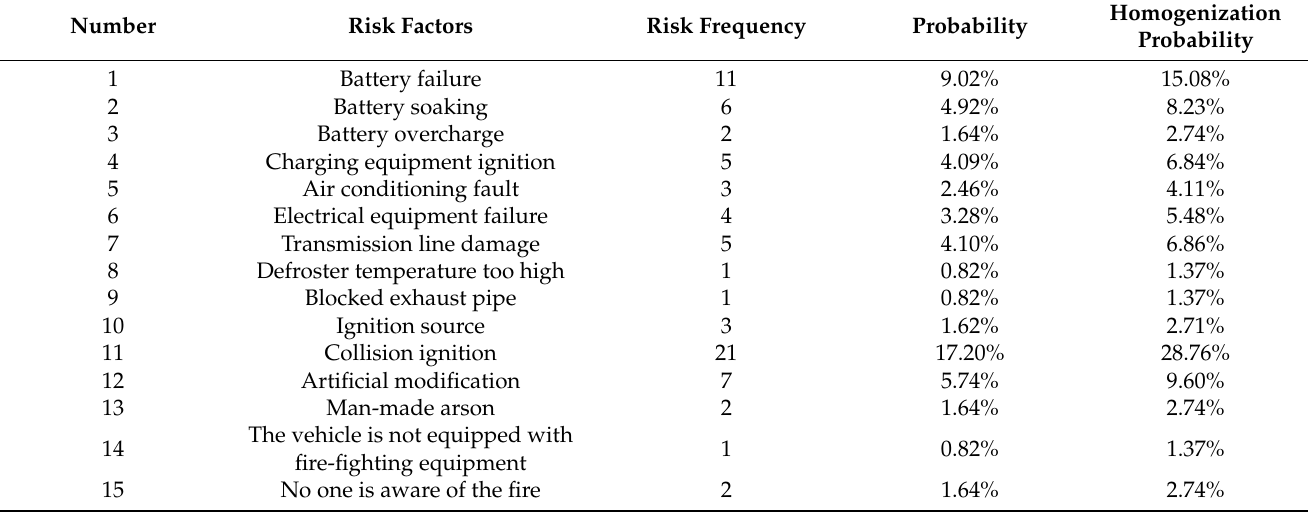
Table A2. Expert language